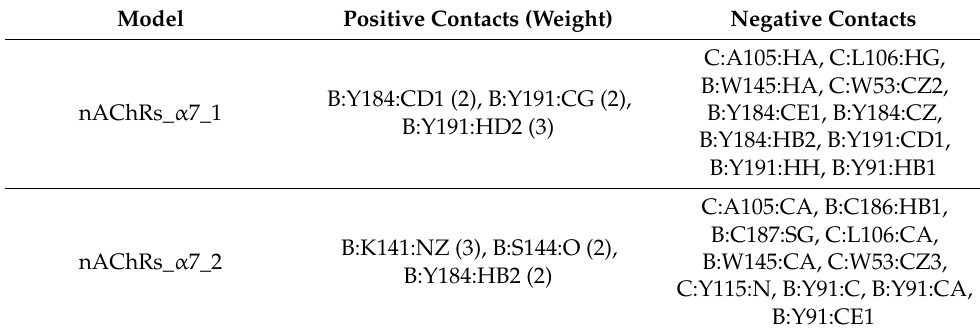
Table 4. Critical contacts for the two best dbCICA models for α 7